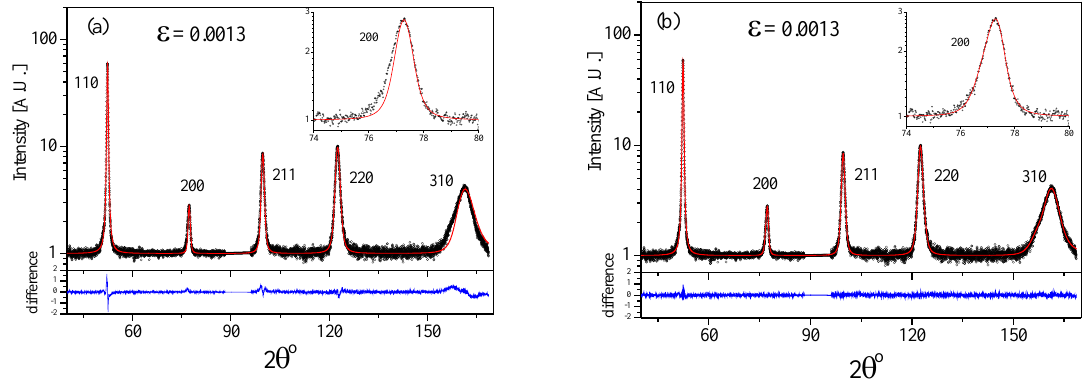
Figure 2. Typical axial di ff raction patterns corresponding to the ε = 0.0013 tensile deformed state. ( a ) Each peak is fitted in convolutional multiple whole profile (CMWP) with a single symmetrical profile. ( b ) Each peak is fitted in CMWP with the sum of two symmetrical sub-profiles. Black dots are the measured data, red lines are the CMWP calculated patterns and the blues line at the bottom are the di ff erence between the measured and calculated patterns. Note the logarithmic intensity scales for the patterns. The insets show the enlarged 200 peaks.